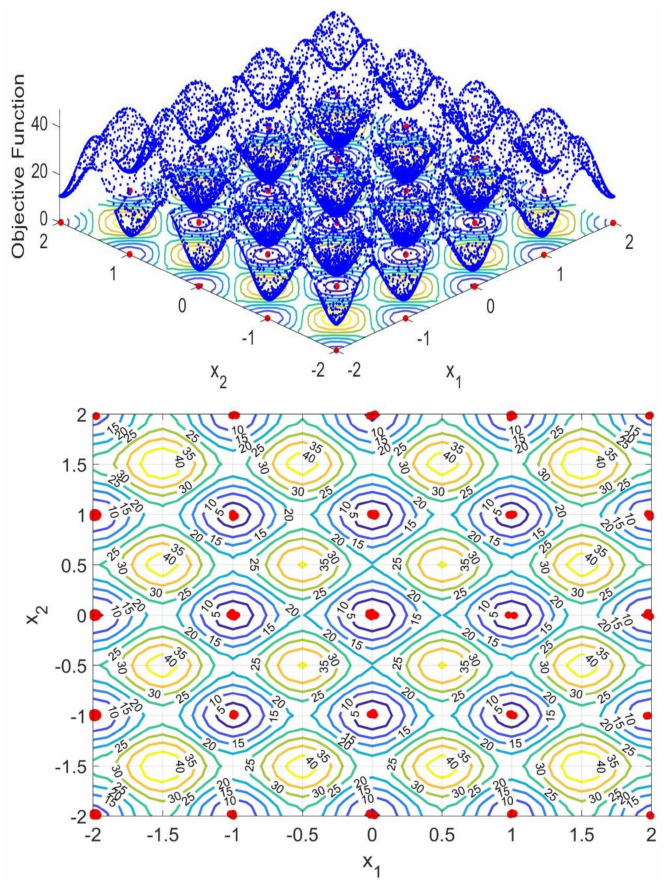
Figure 5. Rastrigin Function 3D topography drawn by the proposed CSPSO and its corresponding 2D map of the local and global minima, with the confidence regions drawn by the deduced likelihood test. A surface map of the objective function is also presented in order to show the location and values of all